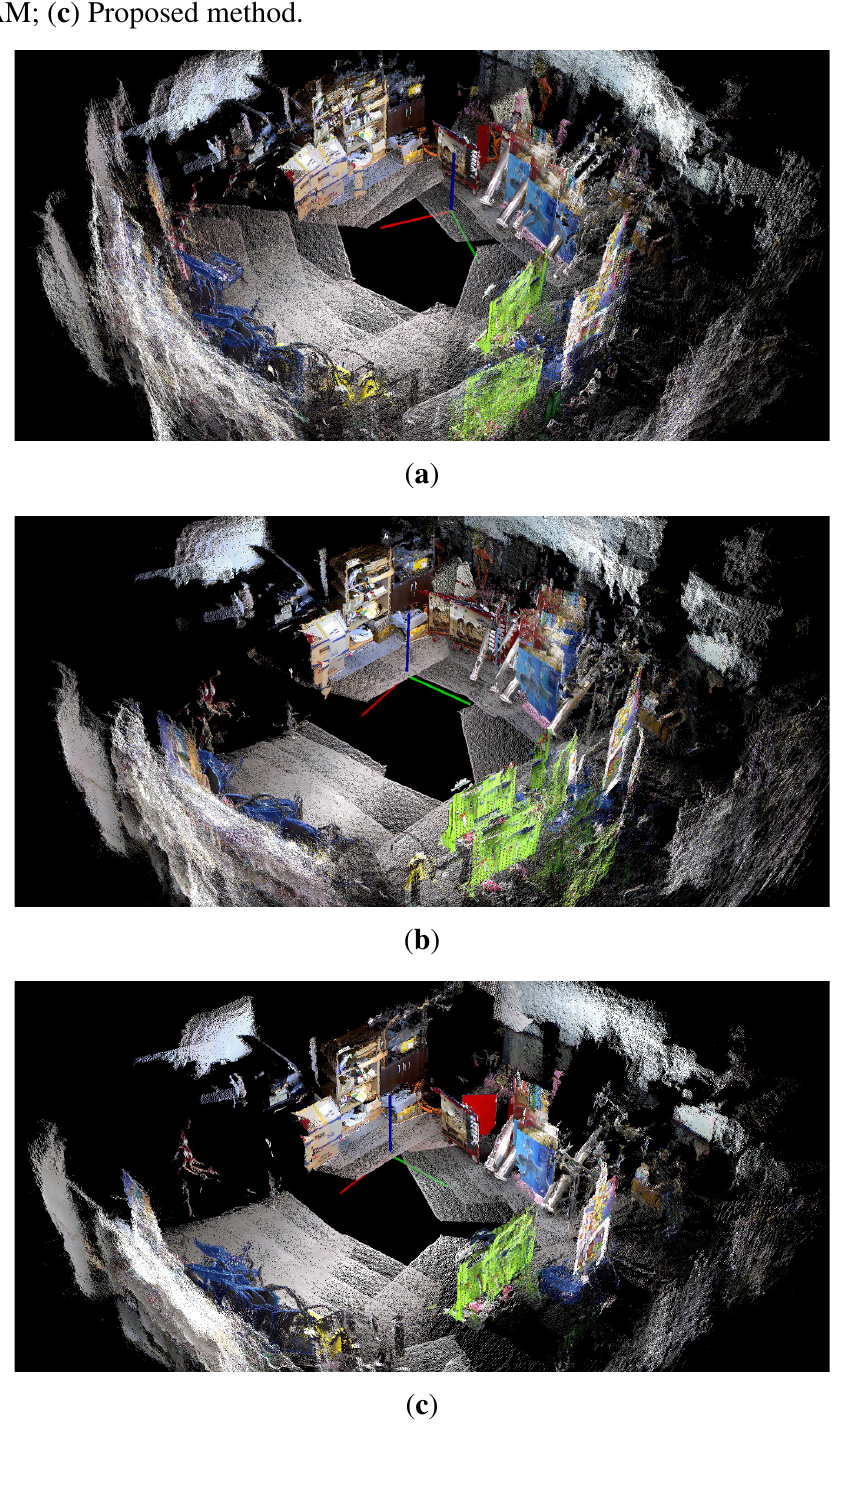
Figure 29. The 3D maps obtained from experiment 3. ( a ) Odometry only; ( b ) Conventional graph SLAM; ( c ) Proposed